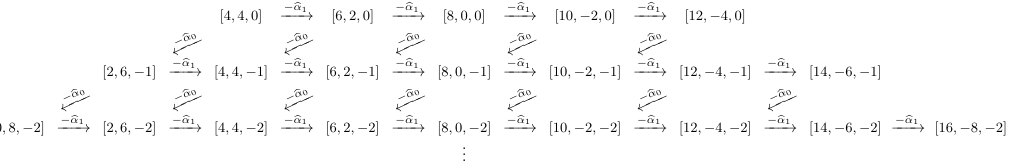
Table 8 . Representation with highest weight [4 ; 4 ;